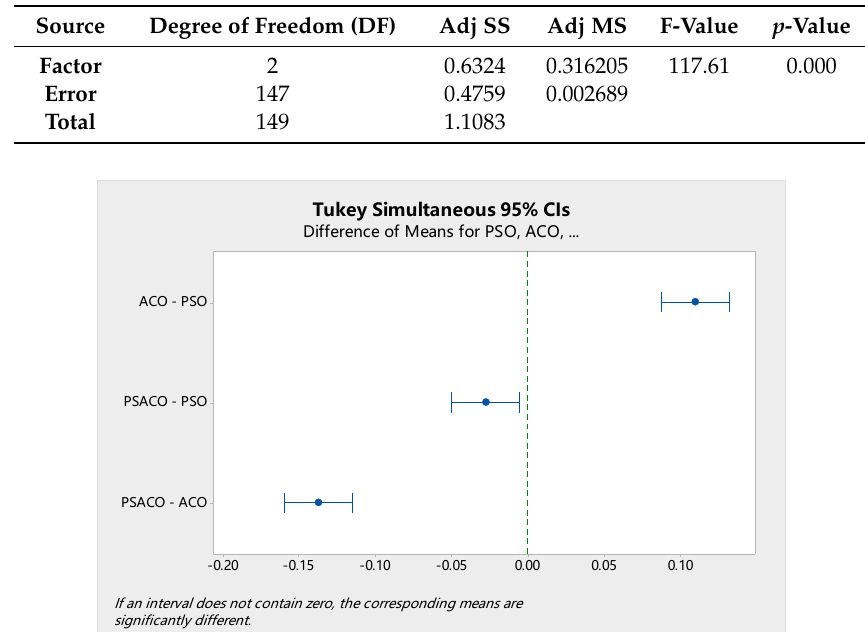
Figure 10. Comparison among PSO, ACO and PSACO. Table 2. Analysis of variance (ANOVA) results for PSO, ACO and PSACO.